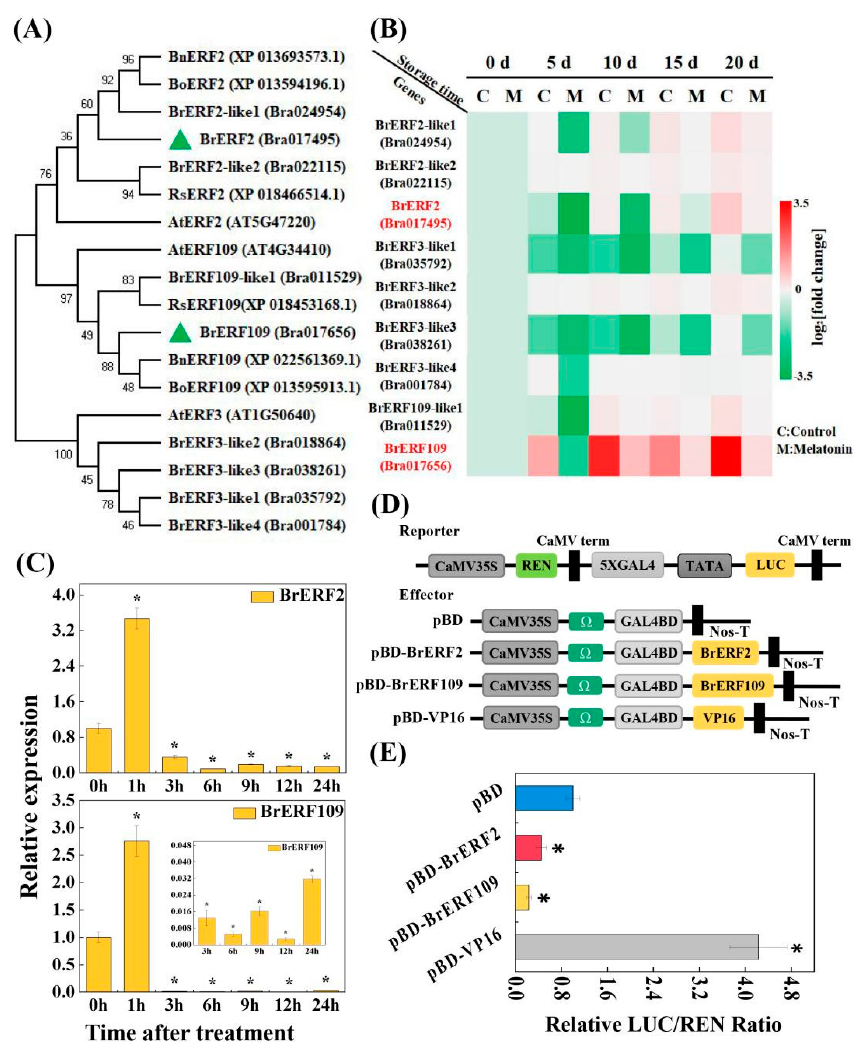
Figure 4. Identification and expression pattern analysis of BrERFs . ( A ), Phylogenetic tree analysis between ERFs protein in published species and BrERFs protein of flowering Chinese cabbage. The phylogenetic analysis was performed using the MEGA7.0 software. ( B ), The differential expression levels of nine BrERFs under melatonin treatment. The heatmap indicates the log 2 -(fold change) levels, red: increase; green: decrease. ( C ), The transcription levels of BrERF2 and BrERF109 in growing plants under melatonin treatment. ( D ), Schematic diagram of the effectors, reporters, and internal compositions. ( E ), Transcriptional regulatory activities of BrERF2 and BrERF109. The empty pBD (set as 1) and pBD-VP16 vectors were used as the negative and positive controls, respectively. Each value indicates the mean ± SD of six biological replicates. The asterisks above columns indicate a significant difference at * p < 0.05.